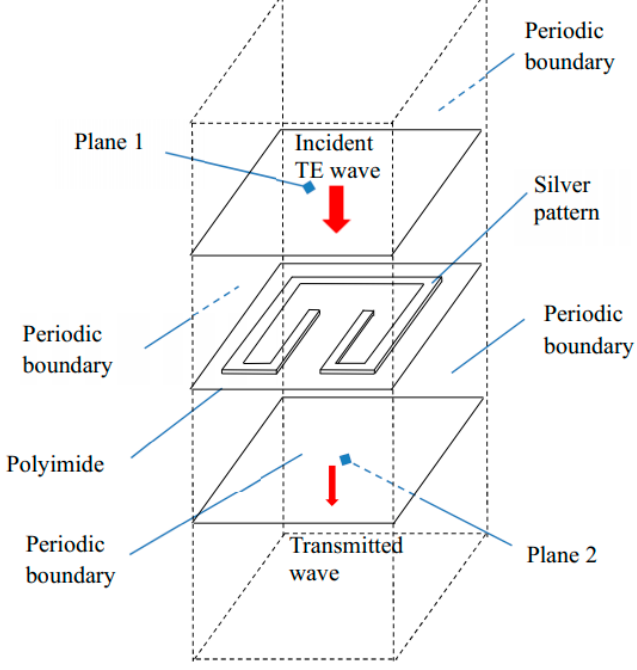
Figure 2. Solution domain.